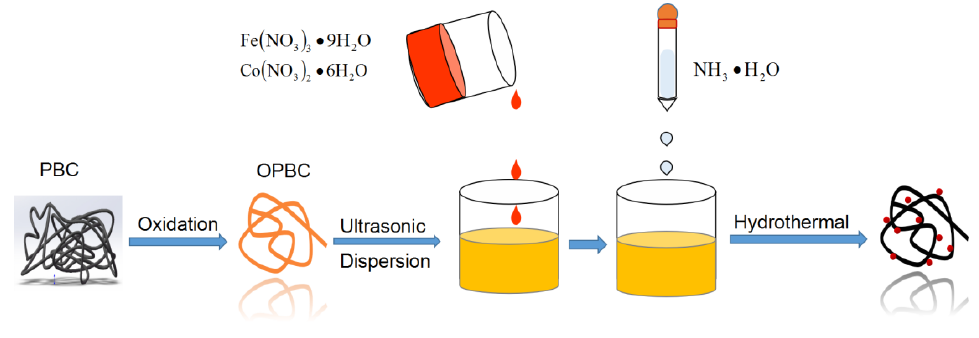
Figure 1. Preparation of the CFO@PBC samples.